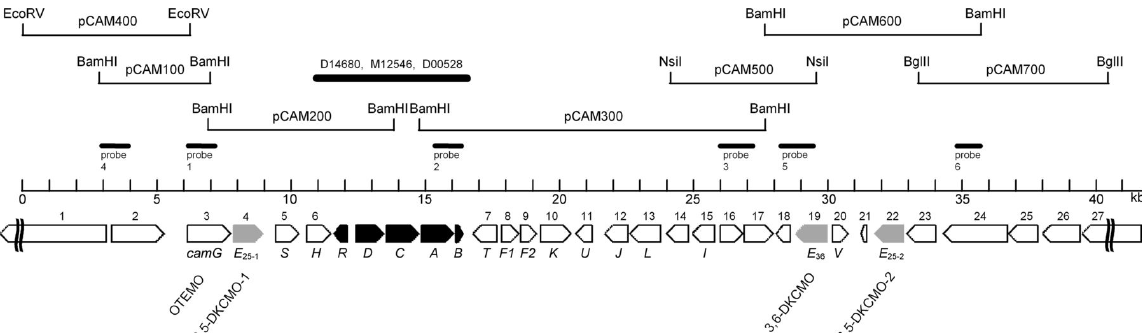
Figure 7. Localization of additional genes and predicted open reading frames (ORFs) flanking the established initial genes of the camphor camDCAB operon and its repressor, camR , on an~40.5-kb sequenced region of the CAM plasmid of P. putida ATCC 17453. The predicted ORFs or genes are numbered from 1 to 27, except for the established camRDCAB genes, which are shaded in black. The orientation of the arrows indicates the direction of gene transcription. The candidate genes of this study ( camE 25–1 , camE 25–2 , and camE 36 ) representing the three diketocamphane monooxygenase (DKCMO) isozymes are highlighted in grey. The previously established OTEMO-encoding gene been designated camG in accordance with the respective catabolic step. Figure reproduced from Iwaki et al. [44] with permission. American Society for Microbiology, licence number